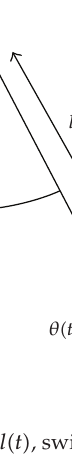
Figure 1: Sketch of a piston moving a gas (cid:4) according to x (cid:6) εx p (cid:4) t (cid:5)(cid:5) in an open tube.